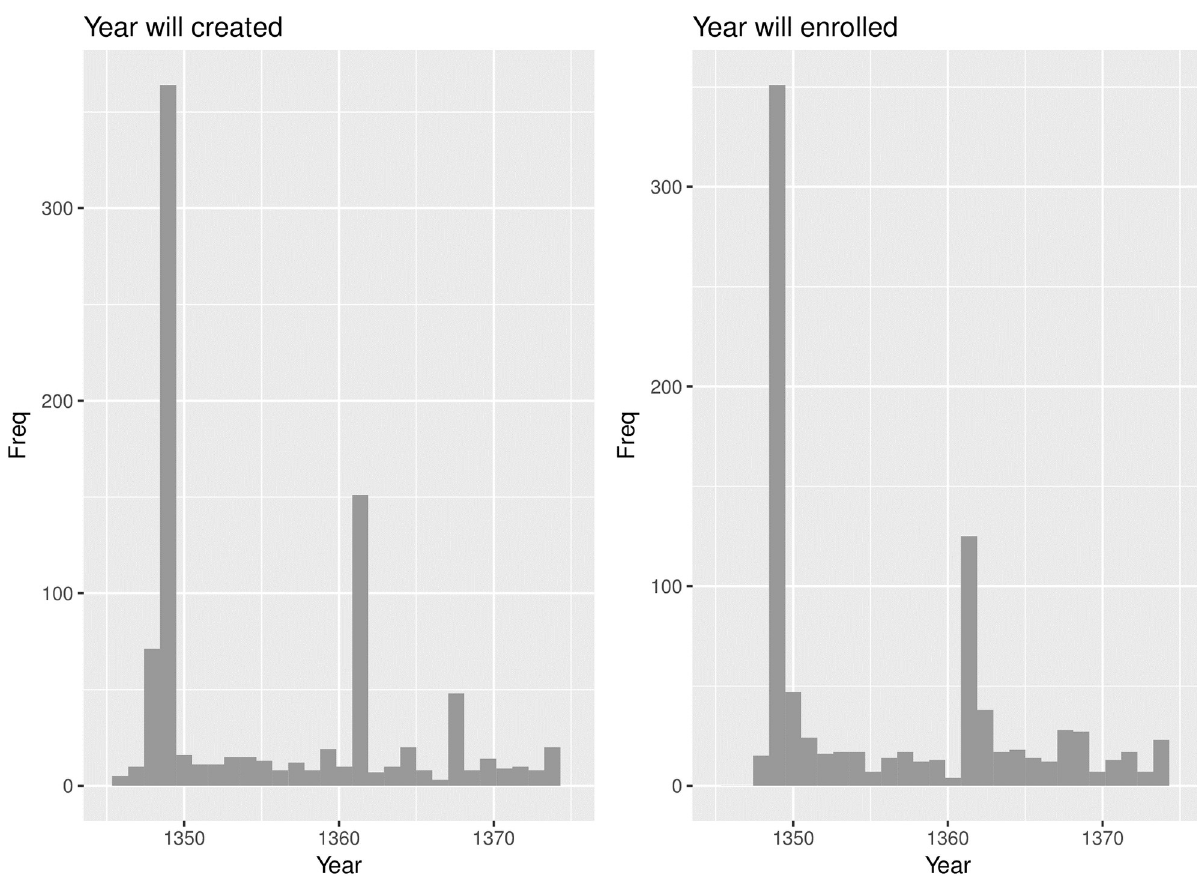
Fig 3. Data used. Histograms of wills created and enrolled in the data considered.